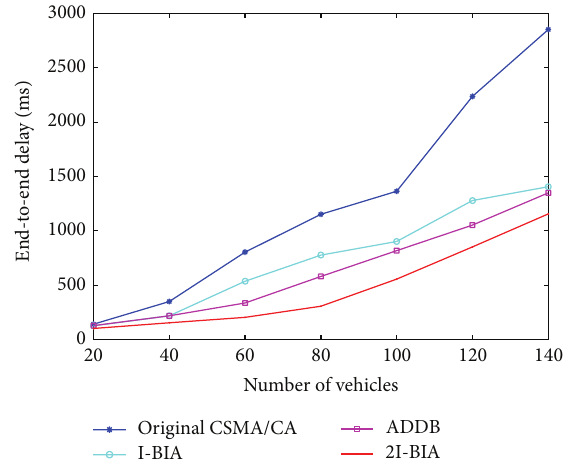
Figure 5: End-to-end delay of an EWM packet with various numbers of vehicles.